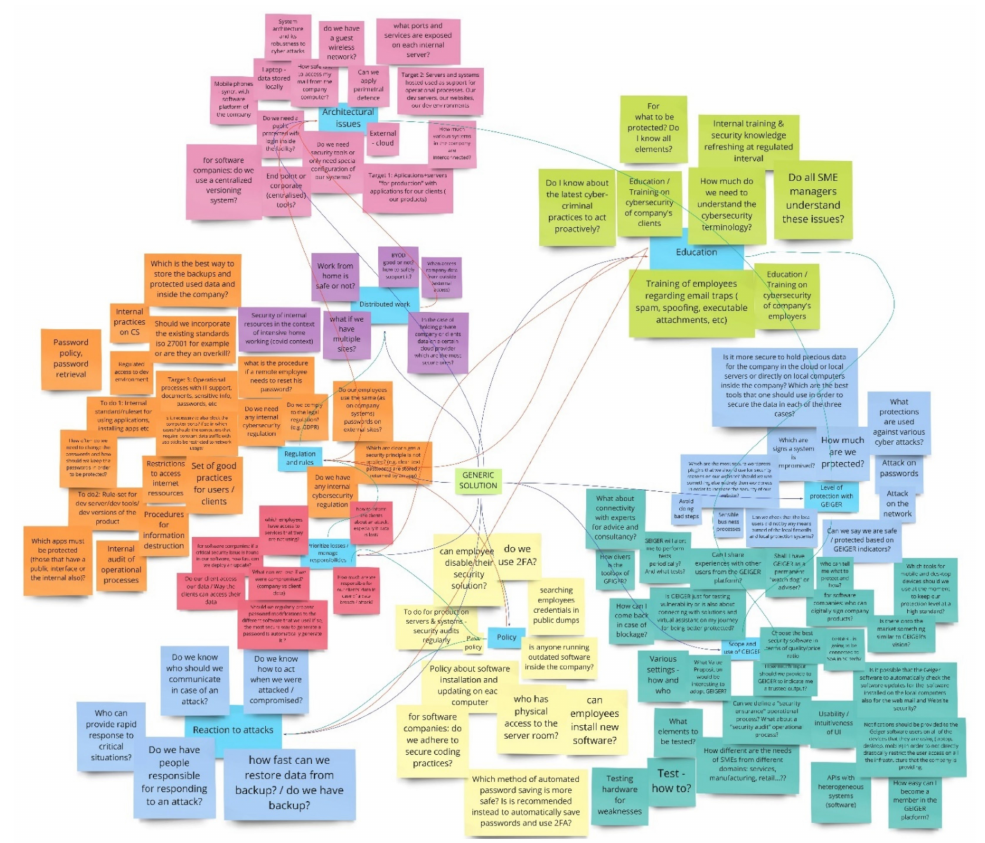
Figure 4. A section from the mind-map